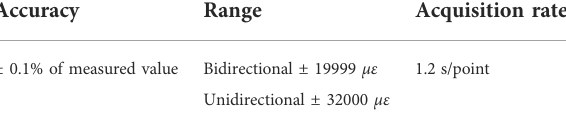
TABLE 2 The speci fi c indexes of